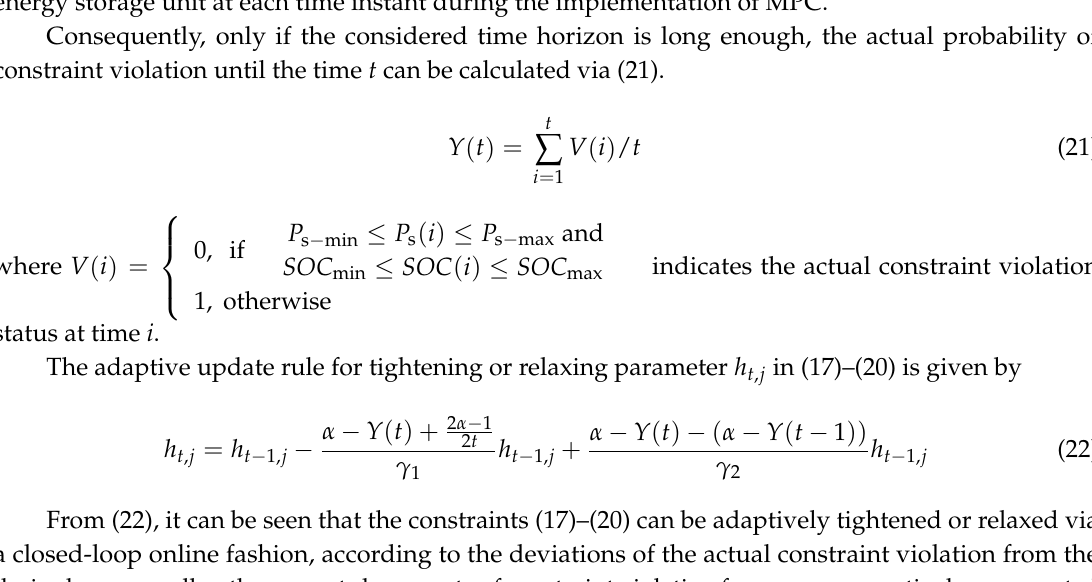
can improve the dynamic performance of constraint violation.